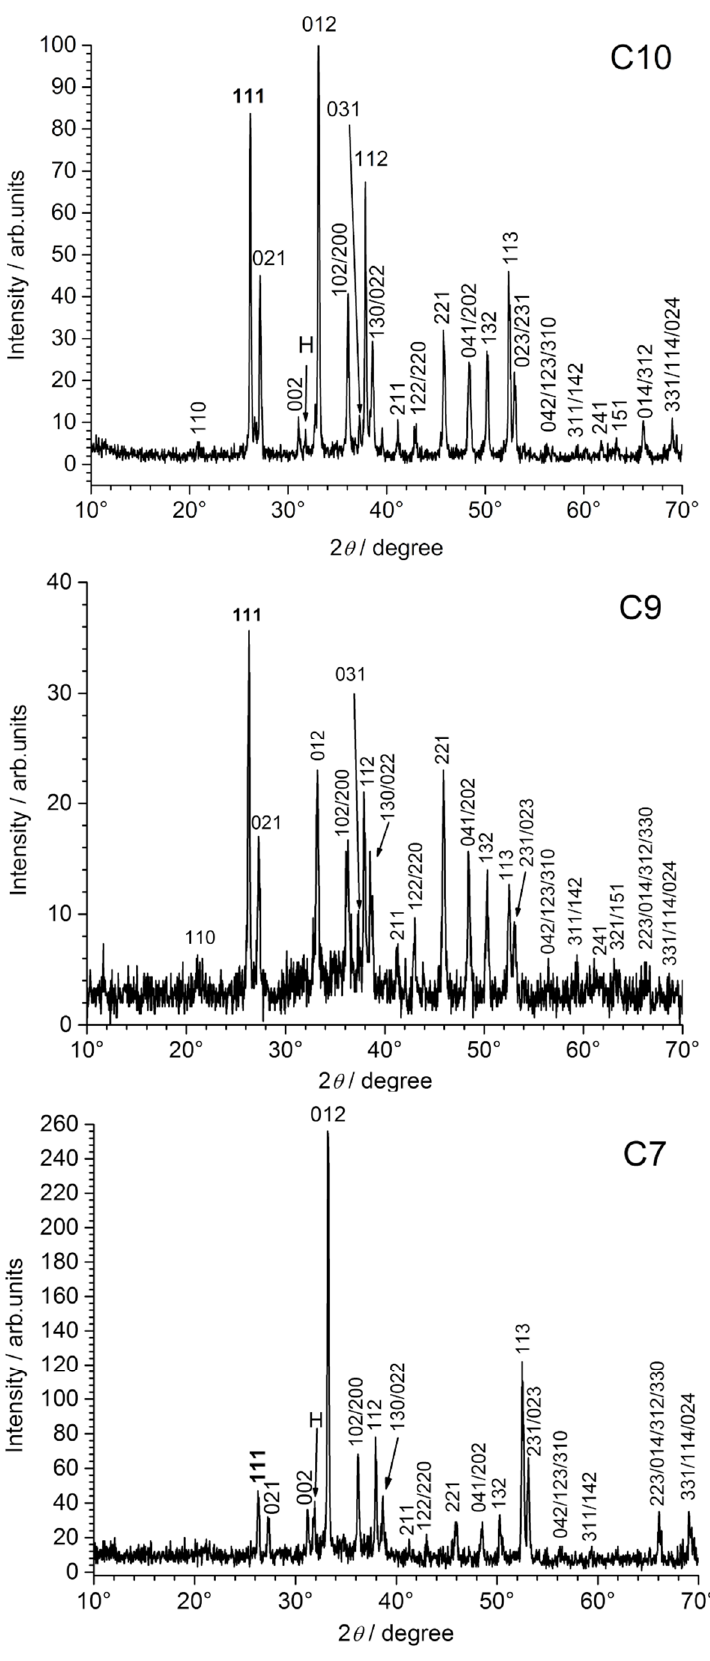
Figure 9. XRD analysis of coupons C10, C9 and C7. The diffraction lines of aragonite are denoted with the corresponding Miller index. H = main diffraction line of halite (NaCl).